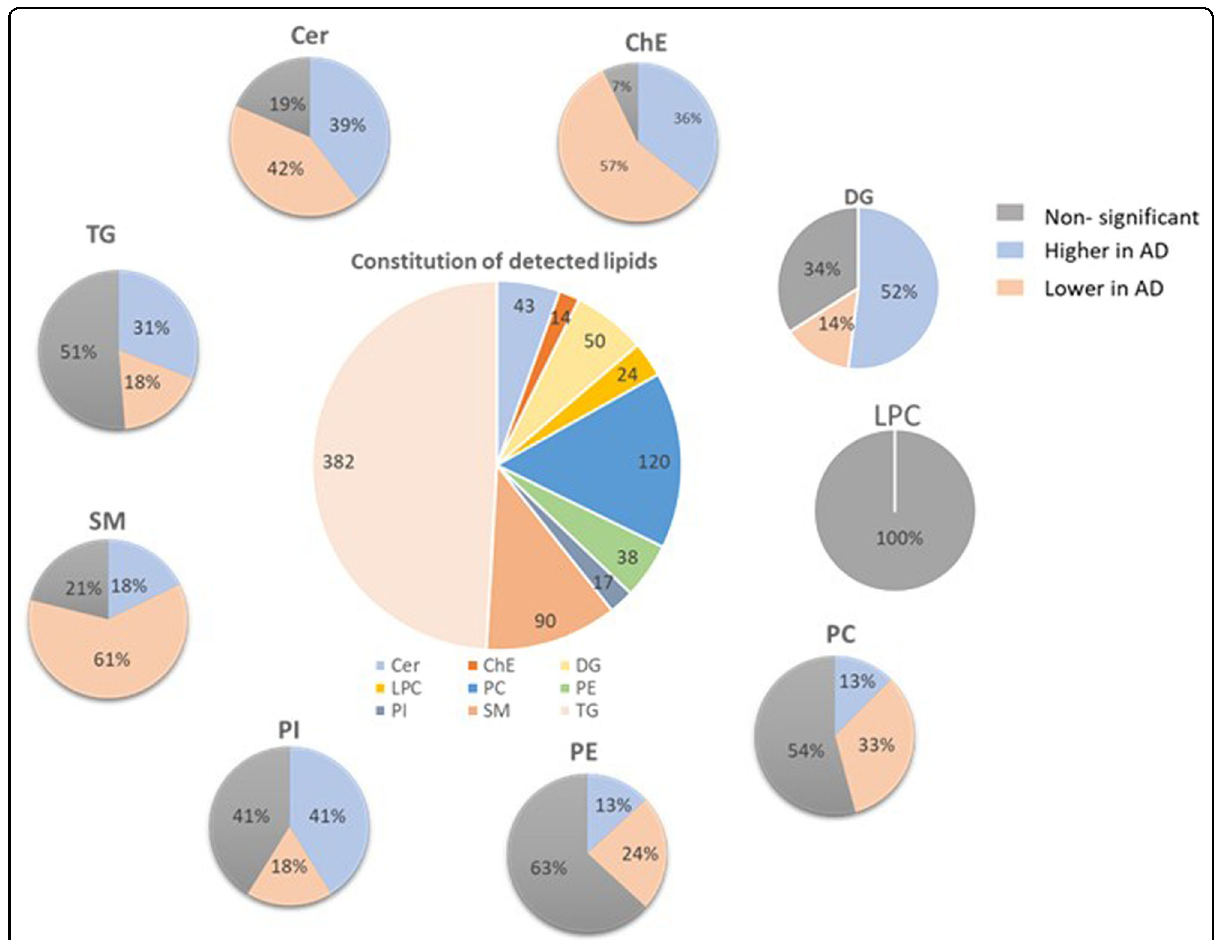
Fig. 1 Proportion of lipids signi fi cantly different between AD and control in lipid classes. Overall pie chart presenting the number of lipids measured in each lipid class. Separate pie charts describing the proportion of lipids with non-signi fi cant differences or signi fi cantly higher/lower in AD versus controls for each lipid class. Cer ceramides, SM sphingomyelins, ChE cholesteryl esters, DG diglycerides, TG triglycerides, PC phosphatidylcholines, LPC lyso-phosphatidylcholines, PE phosphatidylethanolamines, PI